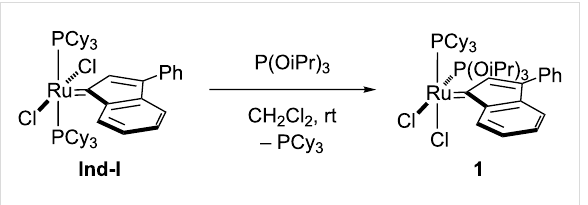
bis[2,4,6-(trimethyl)phenyl]imidazolidin-2-ylidene) afforded